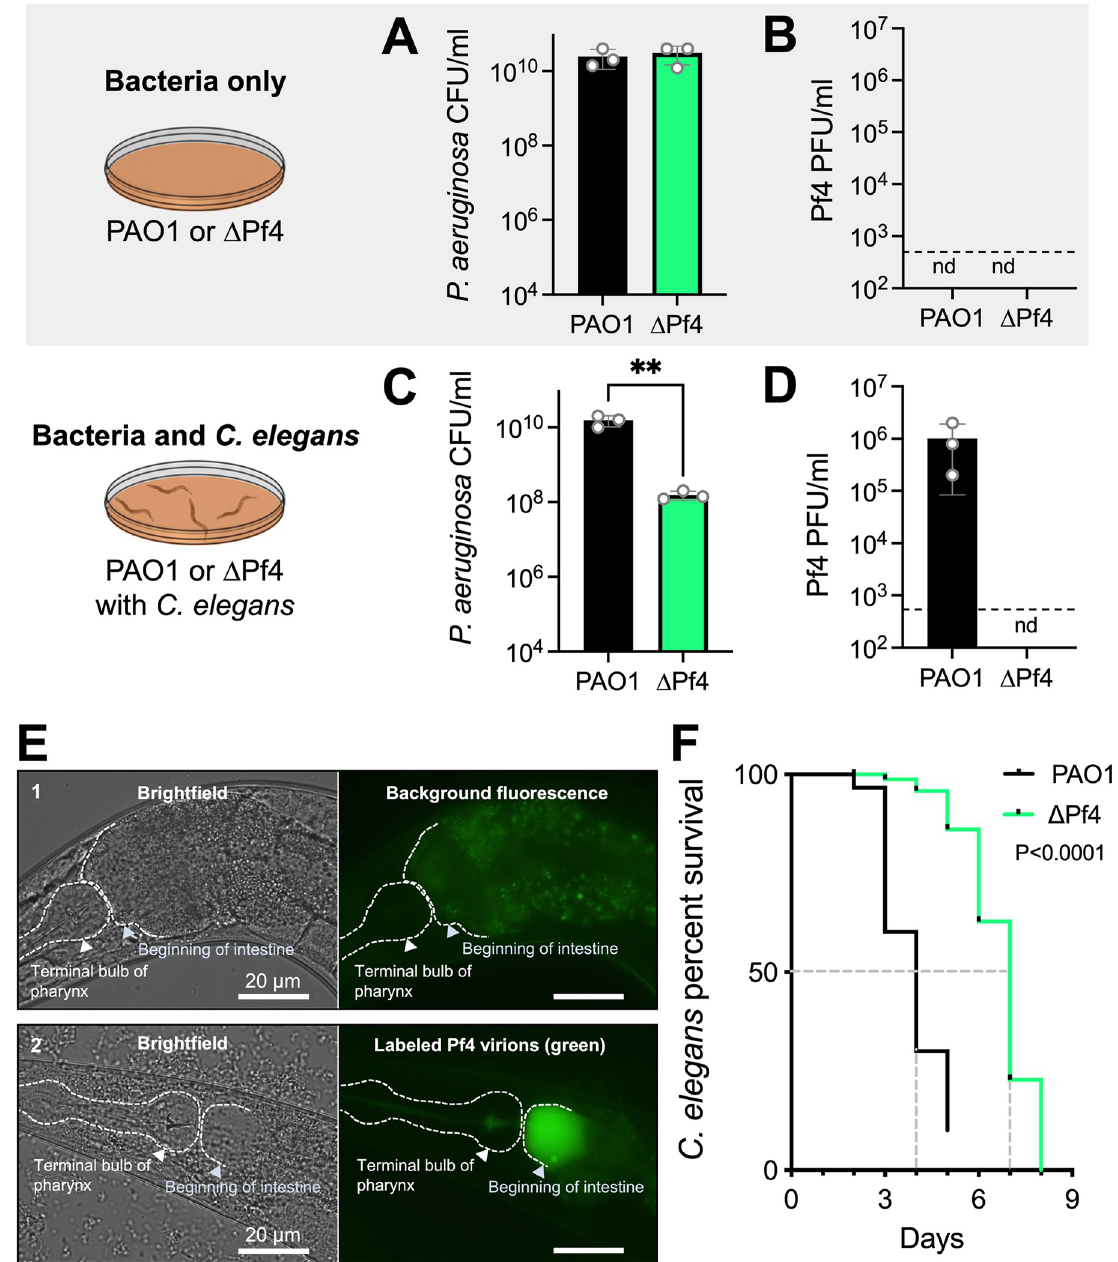
Fig 1. C . elegans predation induces Pf4 replication and enhances P . aeruginosa virulence . (A-D) Bacterial CFUs and Pf4 PFUs were enumerated after three days in the absence (A-B) or presence (C-D) of C . elegans . nd, not detected (below detection limit of 333 PFU/mL indicated by dashed line). Results are the mean ± SD of three experiments, �� P < 0.01, Student’s t -test. (E) Wild-type N2 C . elegans were maintained on lawns of 1) E . coli OP50 (non-pathogenic nematode food) or 2) OP50 supplemented with 10 9 Pf4 virions labeled with Alexa-fluor 488 (green). Representative brightfield and fluorescent images after 24 hours are shown. (F) Kaplan-Meier survival curve analysis of C . elegans exposed to P . aeruginosa . N = 90 worms per condition (three replicate experiments of 30 worms each). The mean survival of C . elegans maintained on lawns of PAO1 was four days compared to seven days for nematodes maintained on lawns of Δ Pf4 (dashed gray lines). Note that worms that may have escaped the dish rather than died were withdrawn from the study, explaining why the black PAO1 line does not reach zero percent